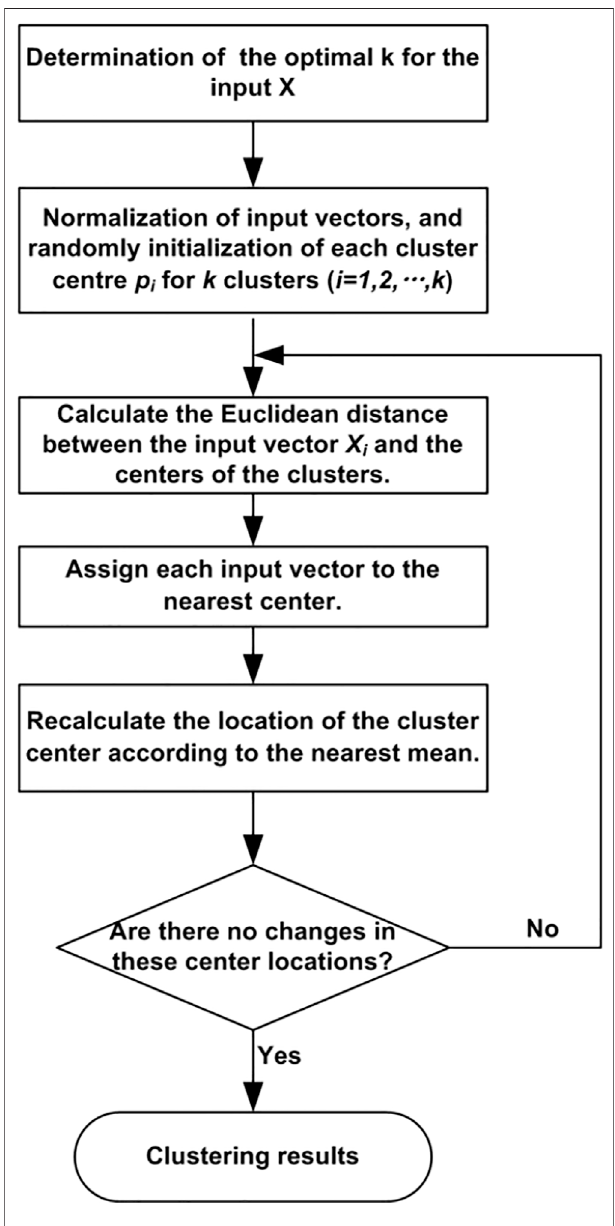
FIGURE 4 | Flow chart of the k -means